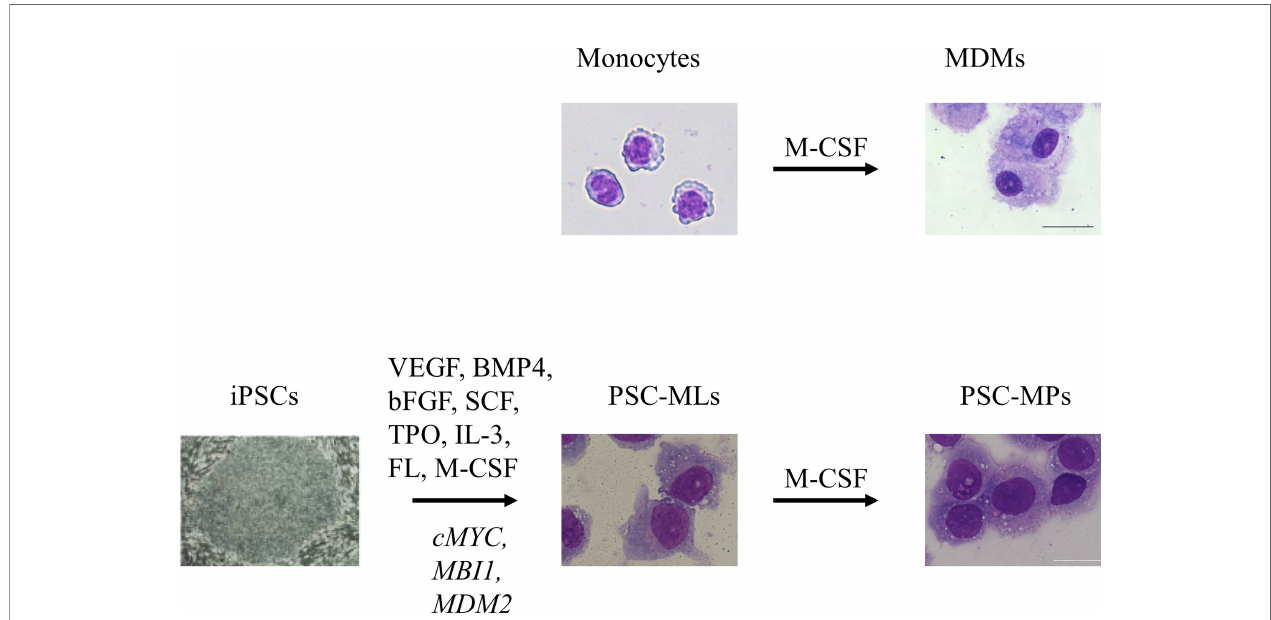
FIGURE 1 | In vitro culture of primary monocytes for 7 days in the presence of macrophage colony-stimulating factor (M-CSF) gives rise to adherent monocyte- derived macrophages (MDMs). Sequential stimulation with VEGF, BMP4, bFGF, SCF, TPO, IL-3, FL, and M-CSF differentiates induced pluripotent stem cells (iPSCs) into fl oating monocyte-like cells. After introduction of three transgenes, namely, cMYC , MBI1 , and MDM2 , into the fl oating cells, PSC-derived immortalized myeloid cell lines (PSC-MLs) begin to proliferate. In vitro culture of PSC-MLs for 7 days in the presence of M-CSF gives rise to adherent PSC-derived macrophages (PSC- MPs). Scale bars, 20 µm. VEGF, vascular endothelial growth factor; BMP4, bone morphogenic protein type 4; bFGF, basic fi broblast growth factor; SCF, stem cell factor; TPO, thrombopoietin; IL-3, interleukin-3; FL, FLT3